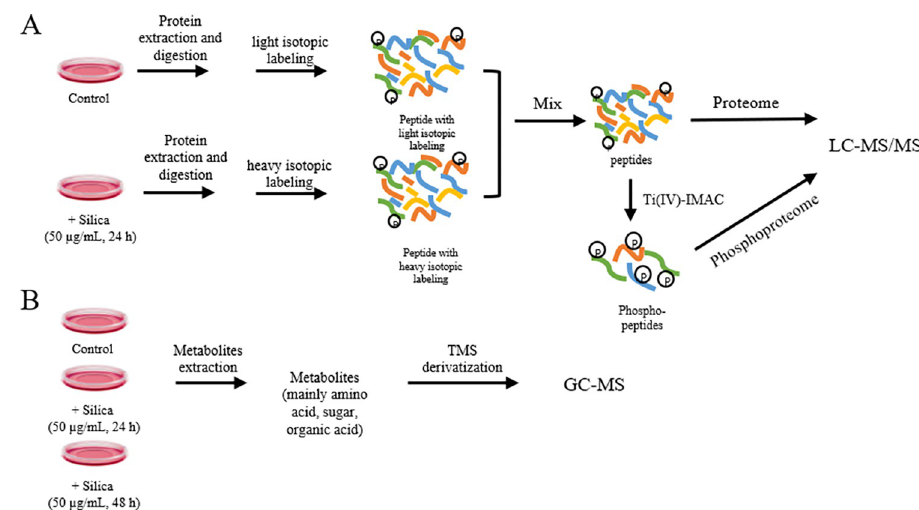
Fig 1. Study design. (A). Proteomics and phosphoproteomic analysis. (B) Metabolic